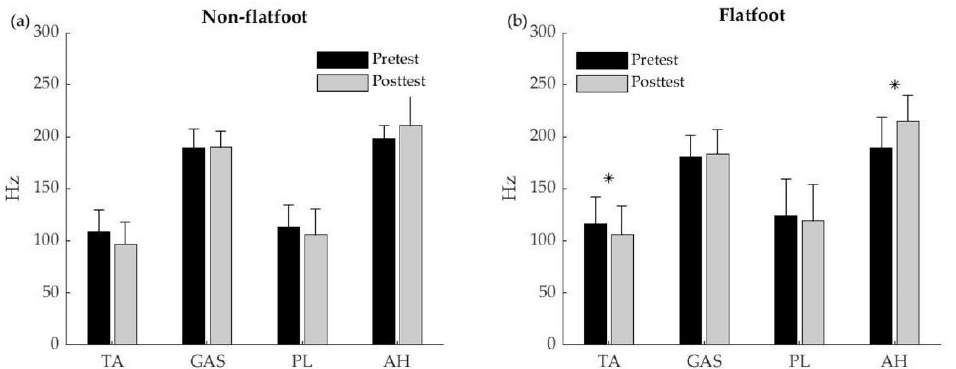
Figure 5. Median frequency for ( a ) non-flatfoot and ( b ) flatfoot groups. * Significant differences between pretest and posttest. TA, tibialis anterior; GAS, gastrocnemius; PL, peroneus longus; AH, abductor hallucis.